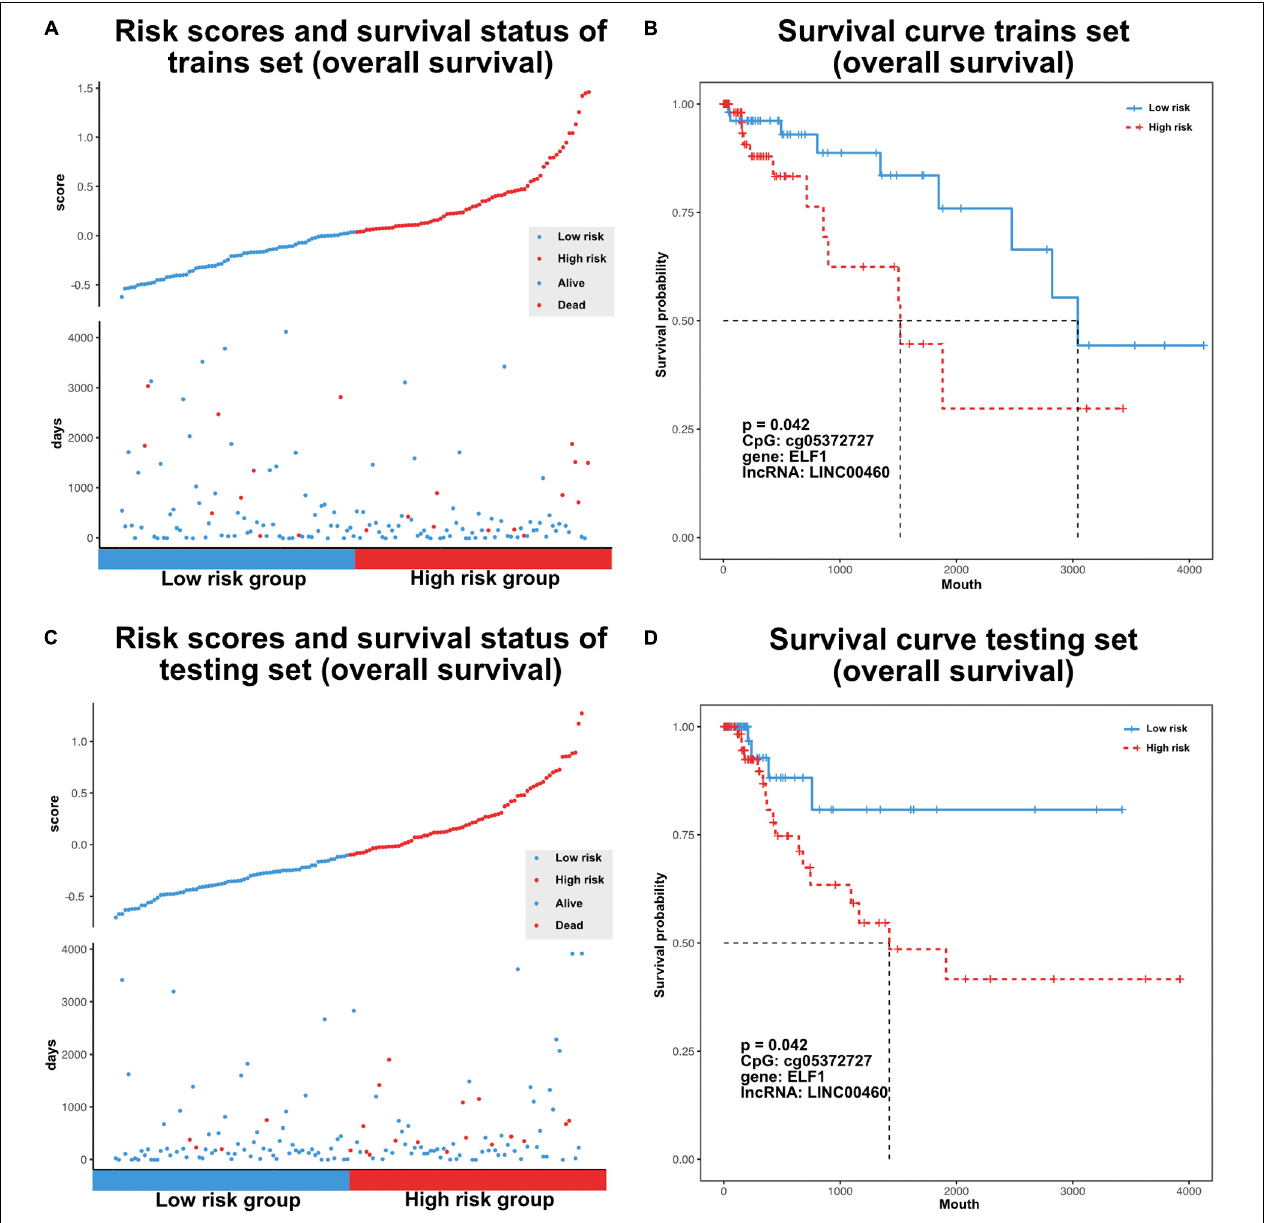
FIGURE 6 | Characterize prognostic related TF-methylation-lncRNA in colon cancer. (A) Scatter plot of risk scores and OS status in TCGA training set. (B) OS curve for two risk groups in TCGA training set, p -value is calculated from log-rank test. (C) Scatter plot of risk scores and OS status in TCGA testing set. (D) OS curve for two risk groups in TCGA testing set, p- value is calculated from log-rank